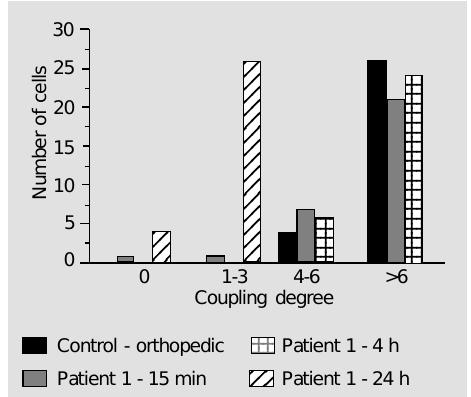
Figure 7 - Time dependence of the uncoupling effects of chagasic sera. Histogram showing the degree of dye coupling in primary cardiomyocyte cultures. The cardio- myocytes were incubated with serum from chagasic patient 1 for different periods of time. Control (black bars) is represented by cardiomyocytes incubated with an orthopedic patient’s serum for 24 h. Incubation with the chagasic patient’s serum for periods of time vary- ing from 15 min up to 4 h did not affect the dye coupling pattern observed in the control condition c 2 ). However, 24 h after incubation with the (P>0.01, chagasic serum coupling was significantly decreased in c 2 comparison to the control group (P<0.01,